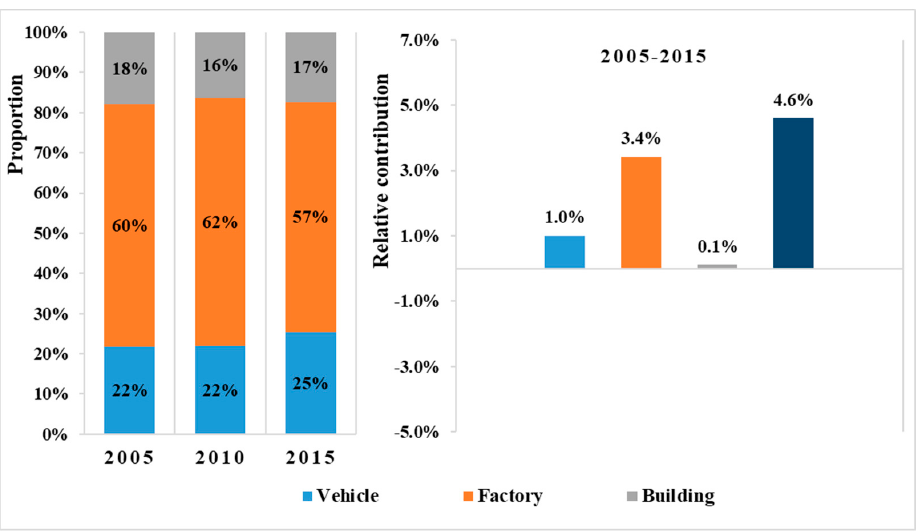
Figure 11. The share of passive structure in China from 2005 to 2015 (Left); Relative contributions of efficiency improvement for passive systems in China from 2005 to 2015 (Right).